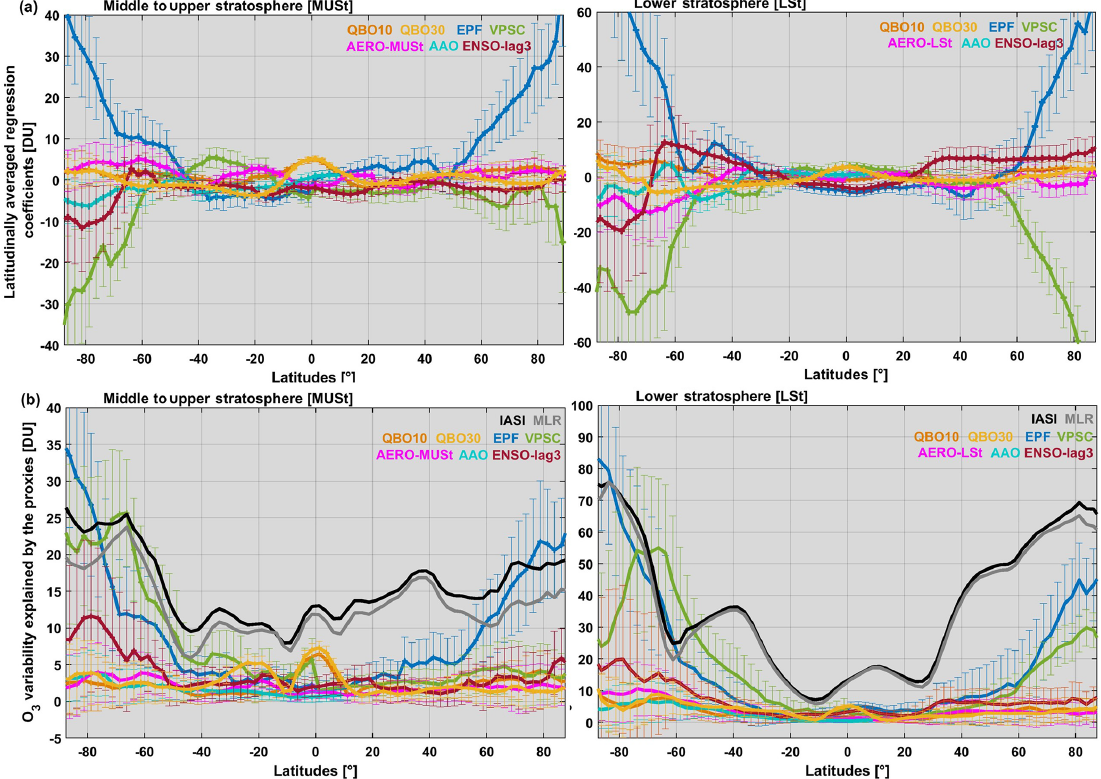
Figure 6. Latitudinal distributions (a) of fitting regression coefficients for various O 3 drivers (QBO10, QBO30, EPF, VPSC, AERO, AAO and ENSO-lag3; in DU) and (b) of 2 σ O 3 variability due to variations in those drivers (in DU) from the annual MLR in MUSt and LSt (left and right panels respectively). Vertical bars correspond (a) to the uncertainty of fitting coefficients at the 2 σ level and (b) to the corresponding error contribution to O 3 variation. Note that the scales are